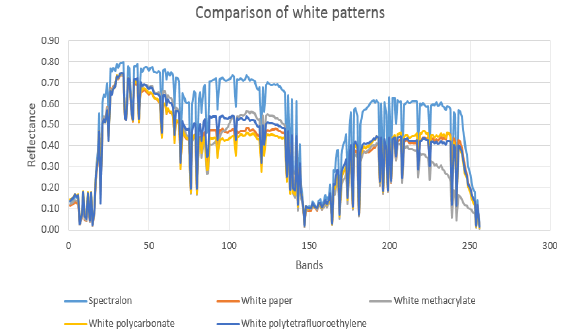
Figure 5. Comparison of the spectral signatures of the white patterns (normalization without ROIs).